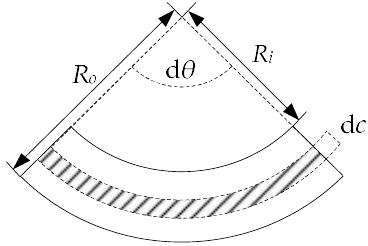
Figure 4. Inductive Electromotive Force Analysis Illustration.